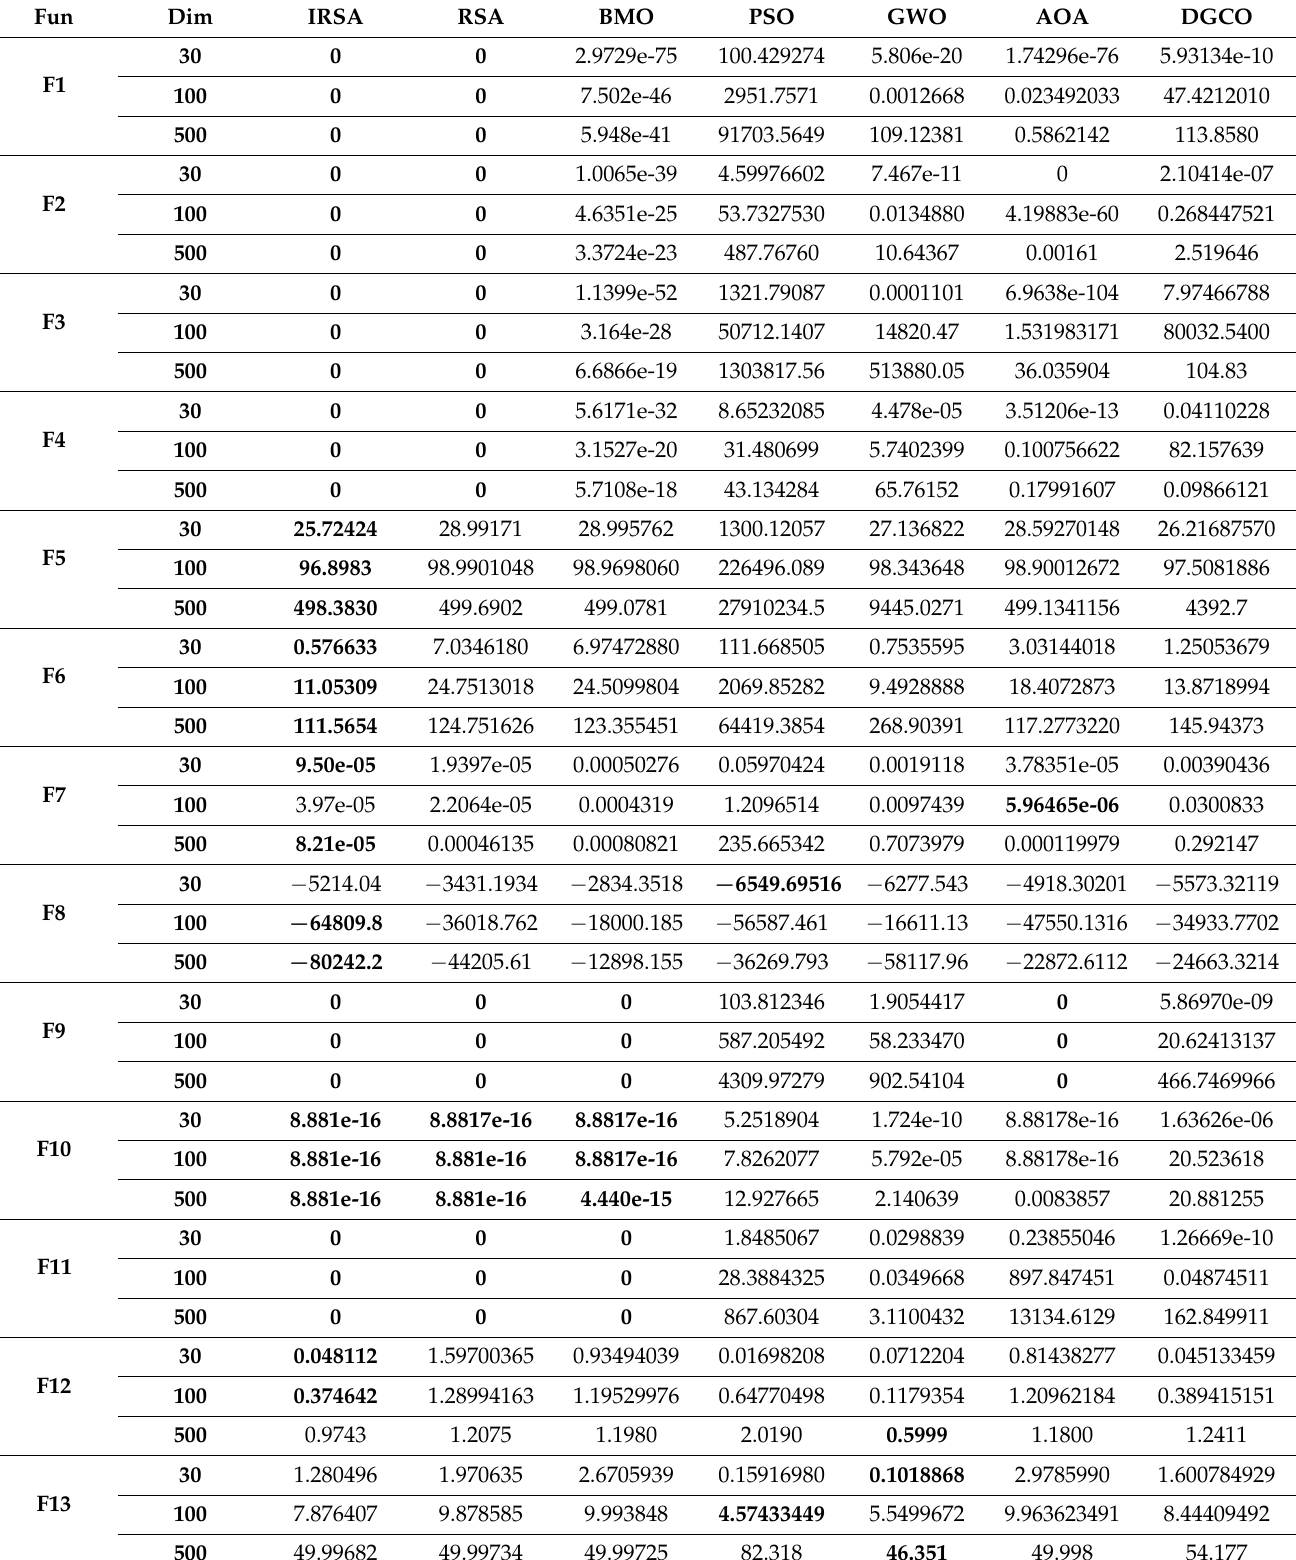
Table 3. Results for unimodal and multimodal functions for 30, 100, and 500 dimensions, 300